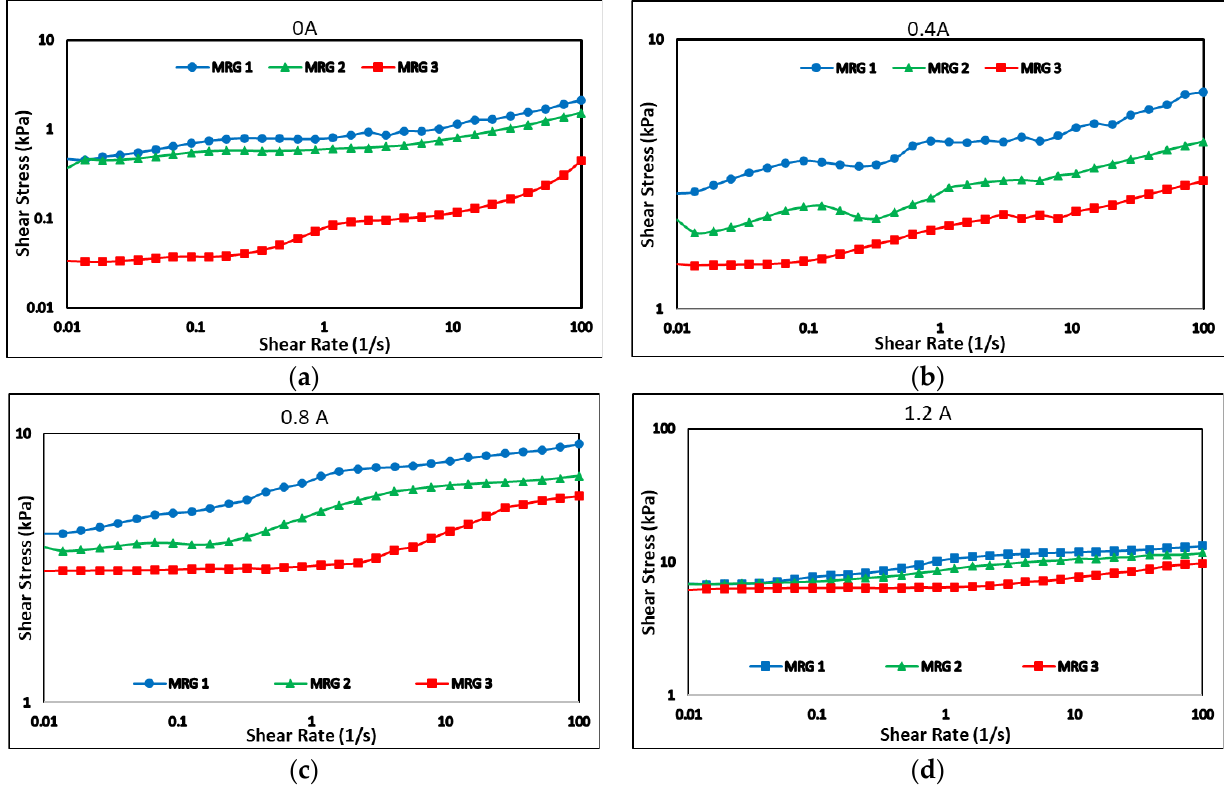
Figure 7. The shear stress of the samples at ( a ) 0, ( b ) 0.4 ( c ) 0.8 and ( d ) 1.2 A of current.